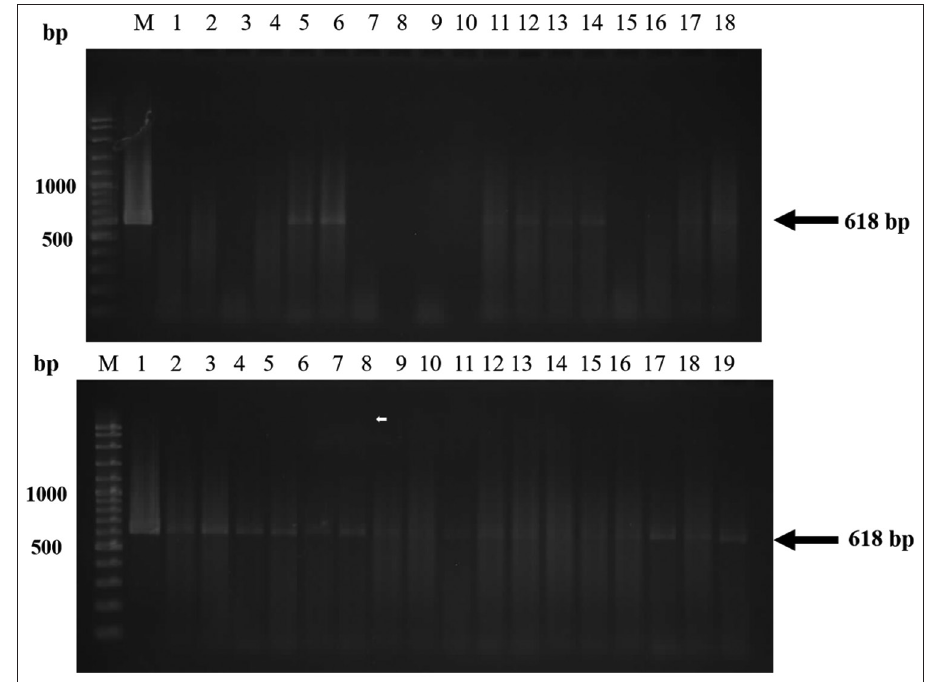
Figure-2: Polymerase chain reaction product 618 bp of partial mitochondria 28s rRNA gene. Lane M: DNA ladder (100 bp). Lane 1: Positive control (adult Fasciola spp.), Lane: 2-18 represent different samples of Fasciola egg.